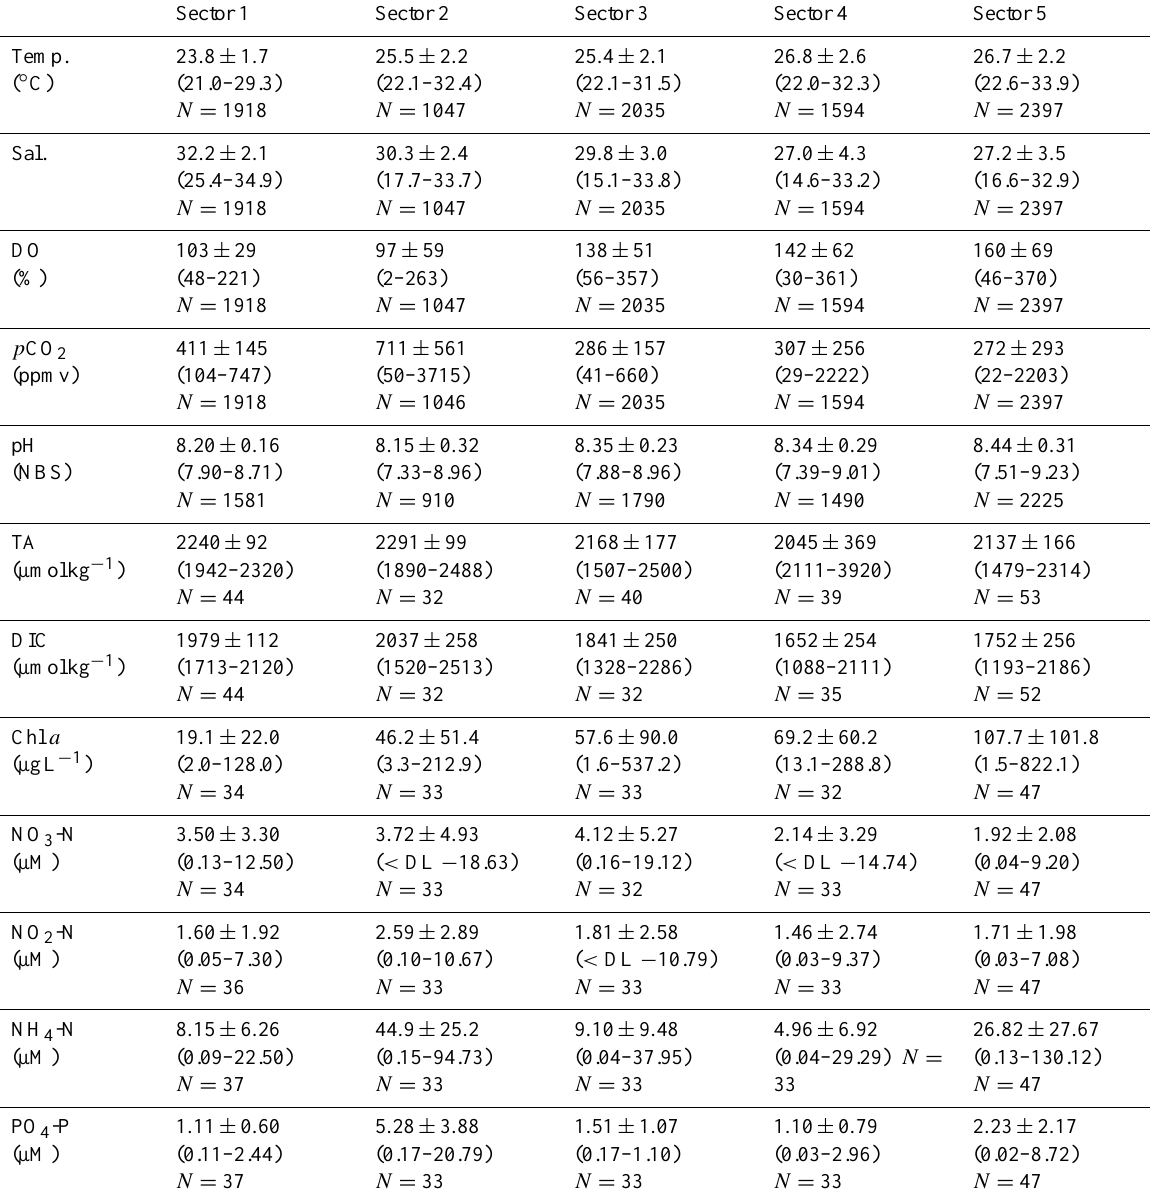
Table 1. Mean ( ± standard deviation), minimum, maximum and number of observations ( N ) of the principal physicochemical properties of the waters of Guanabara Bay for the sampling period, separated by sector. DL: detection limit. Sector 1 Sector 2 Sector 3 Sector 4 Sector 5